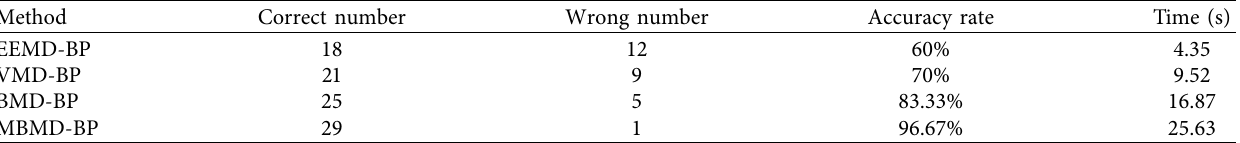
Table 5: The identification accuracy of four decomposition methods combined with the BP neural